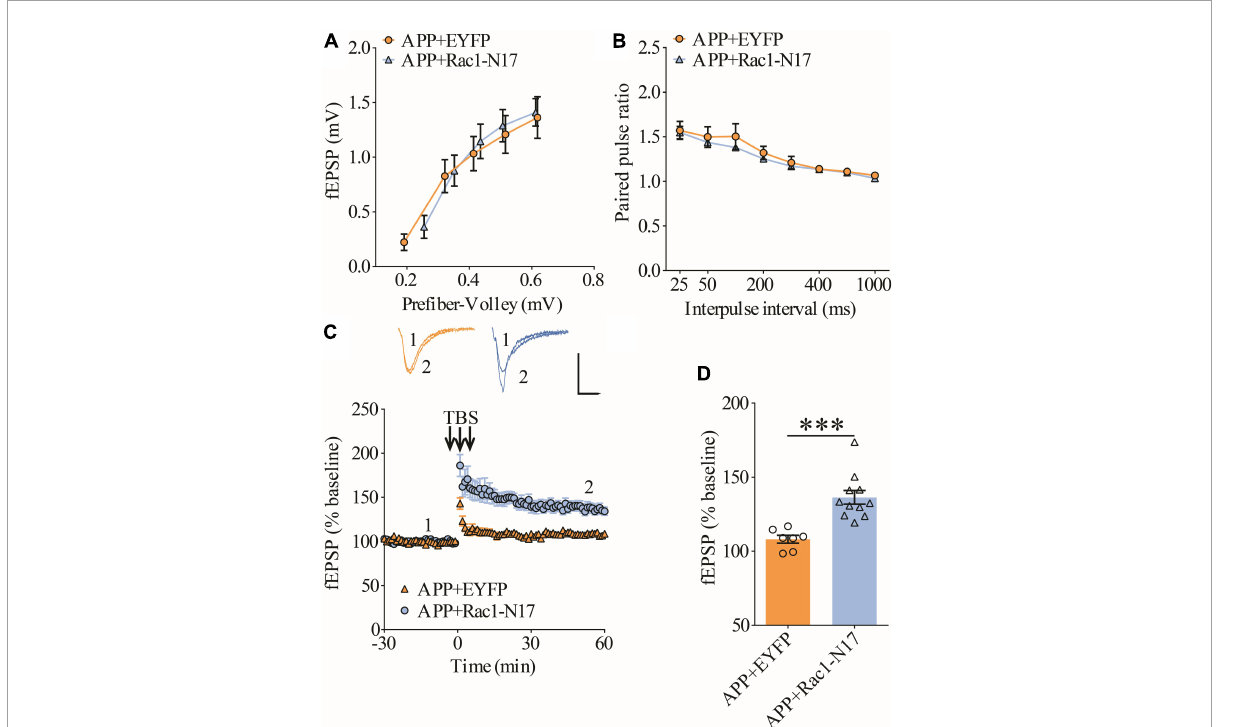
FIGURE5 Improved LTP in APP mice expressing Rac1-N17 in ventral hippocampus. (A) Input–output curves of fEPSP showing no differences between APP mice expressing EYFP and Rac1-N17 (APP + EYFP: n = 8 slices from 4 mice, APP + Rac1-N17: n = 7 slices from 4 mice; genotype: F ( 1 , 15 ) = 0.216, p = 0.652; prefiber volley: F ( 4 , 60 ) = 81.90, p < 0.001; repeated two-way ANOVA). (B) Paired-pulse ratio analysis showing no differences between APP mice expressing EYFP and Rac1-N17 (APP + EYFP: n = 6 slices from 4 mice, APP + Rac1-N17: n = 8 slices from 4 mice; genotype: F ( 1 , 12 ) = 0.472, p = 0.505; inter-pulse interval: F ( 7 , 84 ) = 58.13, p < 0.001; repeated two-way ANOVA). (C) Enhanced LTP in APP/PS1 mice expressing Rac1-N17 compared to EYFP control. Scale bars: 0.4 mV/10 ms. (D) Summary graph of last 10 min of recording showing significantly higher LTP in APP mice expressing Rac1-N17 compared to APP mice expressing EYFP (APP + EYFP: n = 7 slices from 4 mice; APP + Rac1-N17: n = 11 slices from 4 mice; p < 0.001, two-tailed t -test). *** P < 0 .